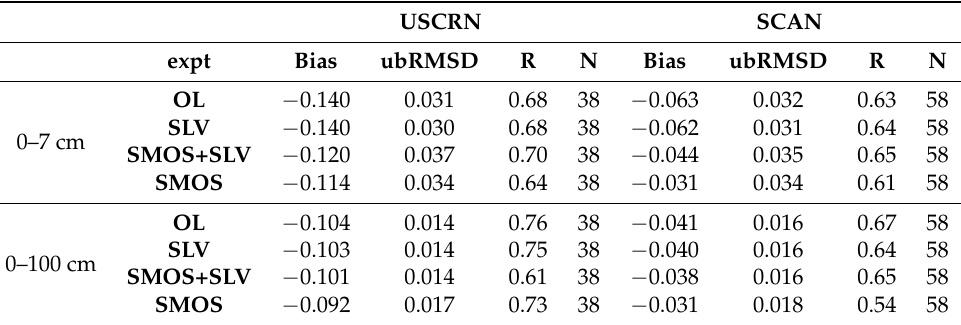
Table 2. Mean Bias, unbiased Root Mean Square Difference (ubRMSD) and time-series correlation coefficient (R) values between the in situ observations (OBS) and the expt type soil moisture analyses (AN) for USCRN and SCAN networks (OBS-AN). Only significant correlation values are used (through the p -value test with a 5% confidence interval). N is the number of stations with significant correlation values for all the experiments compared in this table. For the first metre of soil, in situ observations averaged at depth of 5, 10, 20, 50 and 100 cm were averaged and compared to the average of soil moisture analyses. USCRN SCAN expt Bias ubRMSD R N Bias ubRMSD R N OL − 0.140 0.031 0.68 38 − 0.063 0.032 0.63 − 0.140 0.030 0–7 cm − 0.120 − 0.114 OL − 0.104 − 0.101 0.014